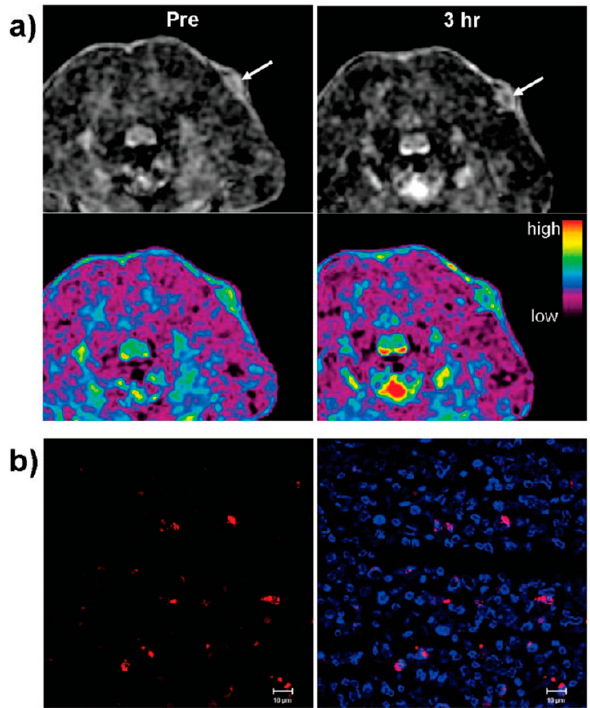
Figure 18. In vivo build-up of Fe 3 O 4 nanostructures in the tumor area. ( a ) In vivo T 2 -weighted MR scans (upper) and color mapped (lower) images of the region of interest before and 3 h after the introduction of Fe 3 O 4 nanoparticles into the bloodstream (the arrows illustrate the cancer area). ( b ) Confocal laser scanning microscopic images of detached cancer tissue accumulated the day after injection. Left: Red fluorescence presenting cells in presence of Fe 3 O 4 . Right: Merged image with 4',6'-diamino-2-fenil-indol (DAPI) stained nuclei (blue) (scale bar 10 µm). Reprinted with permission from